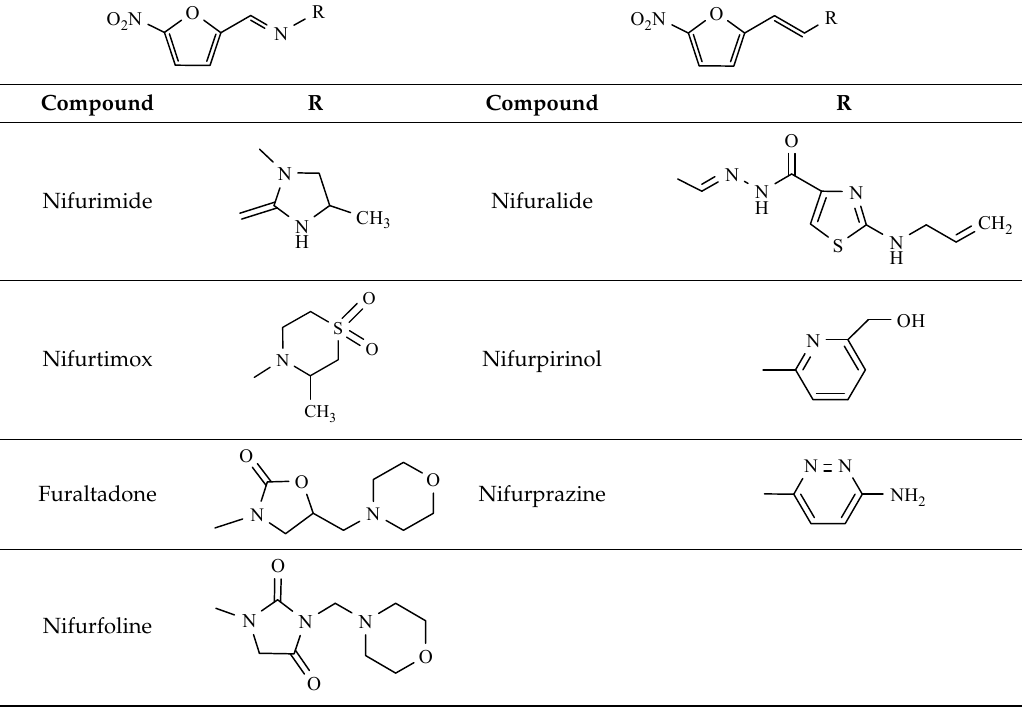
O RO 2 N O RO 2 N